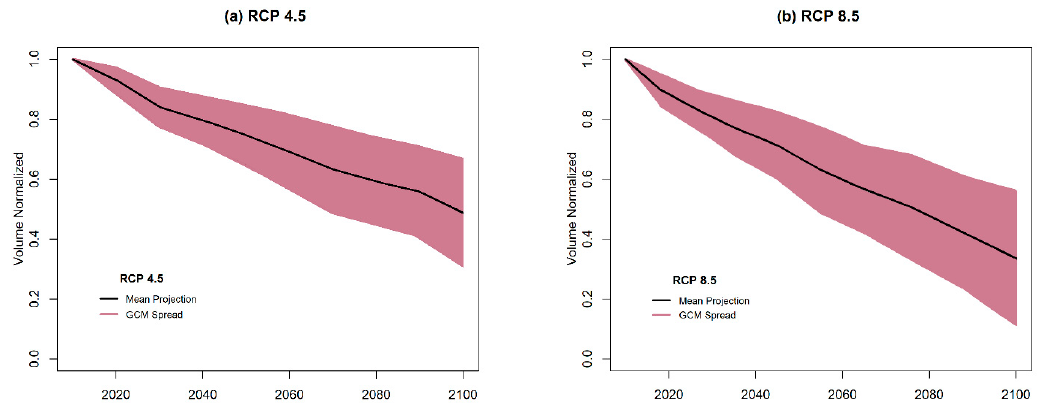
Figure 6. Volume changes on the Universidad Glacier; ( a ): Under RCP 4.5. ( b ): Under RCP 8.5. The volume is normalized by the initial glacier volume.